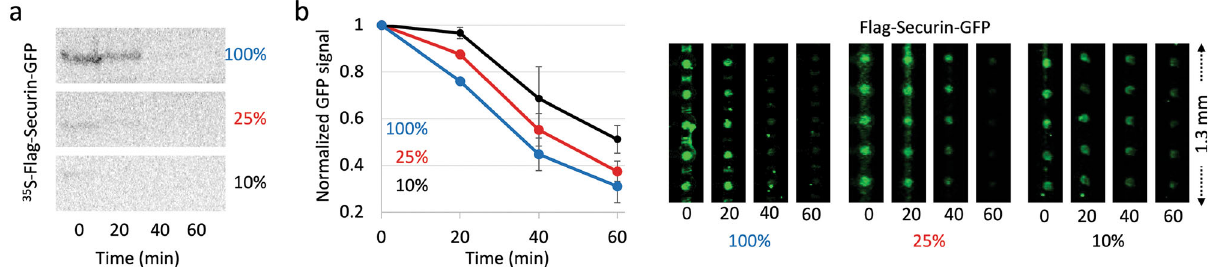
Fig. 4 Method sensitivity. a Time-dependent degradation assay of 35 S-labeled Flag-Securin-GFP in NDB mitotic extracts. Assays were performed with undiluted IVT product (100%) or following 4x/10x dilution in reticulocyte lysate (25 and 10%, respectively). In all assays, 1 µ l substrate was incubated in 20 µ l cell extracts. Samples were snap-frozen in 20 min intervals and assayed by SDS-PAGE and autoradiography. b Equivalent degradation assays performed with non-radioactive Flag-Securin-GFP. Time-point samples were loaded on the chip for immobilization (via anti-GFP-biotinylated antibody) and detection (GFP fl uorescence). The plots summarize data from three experiments, 15 – 20 cell units per experiment. Normalized mean and standard error values are shown (left). Representative raw data are shown on